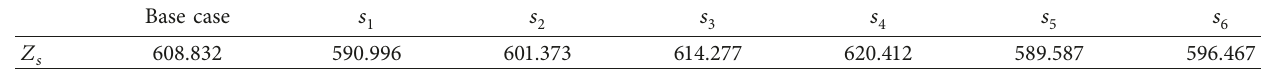
Table 2: The absolute robustness Z